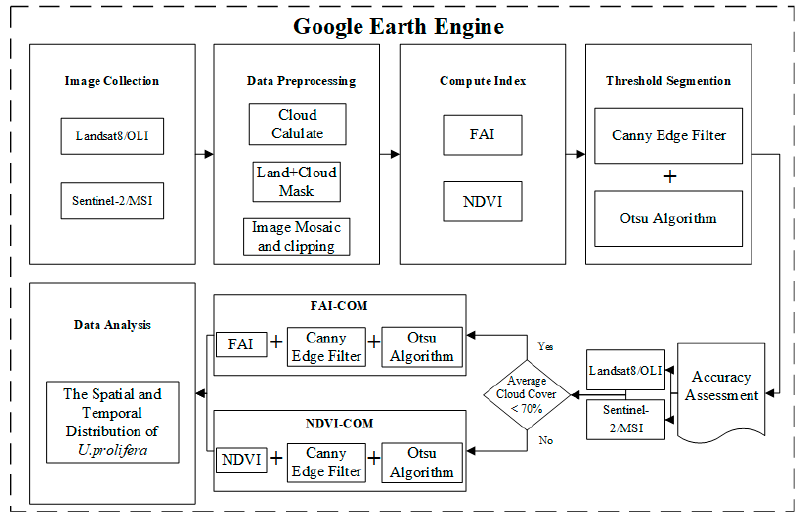
Figure 4. Workflow of adaptive threshold detection